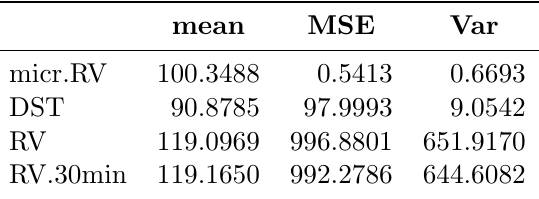
Table 4: Simulation 4. Autocorrelation and changing instantaneous volatility. Annualised volatility: 100.3243%.